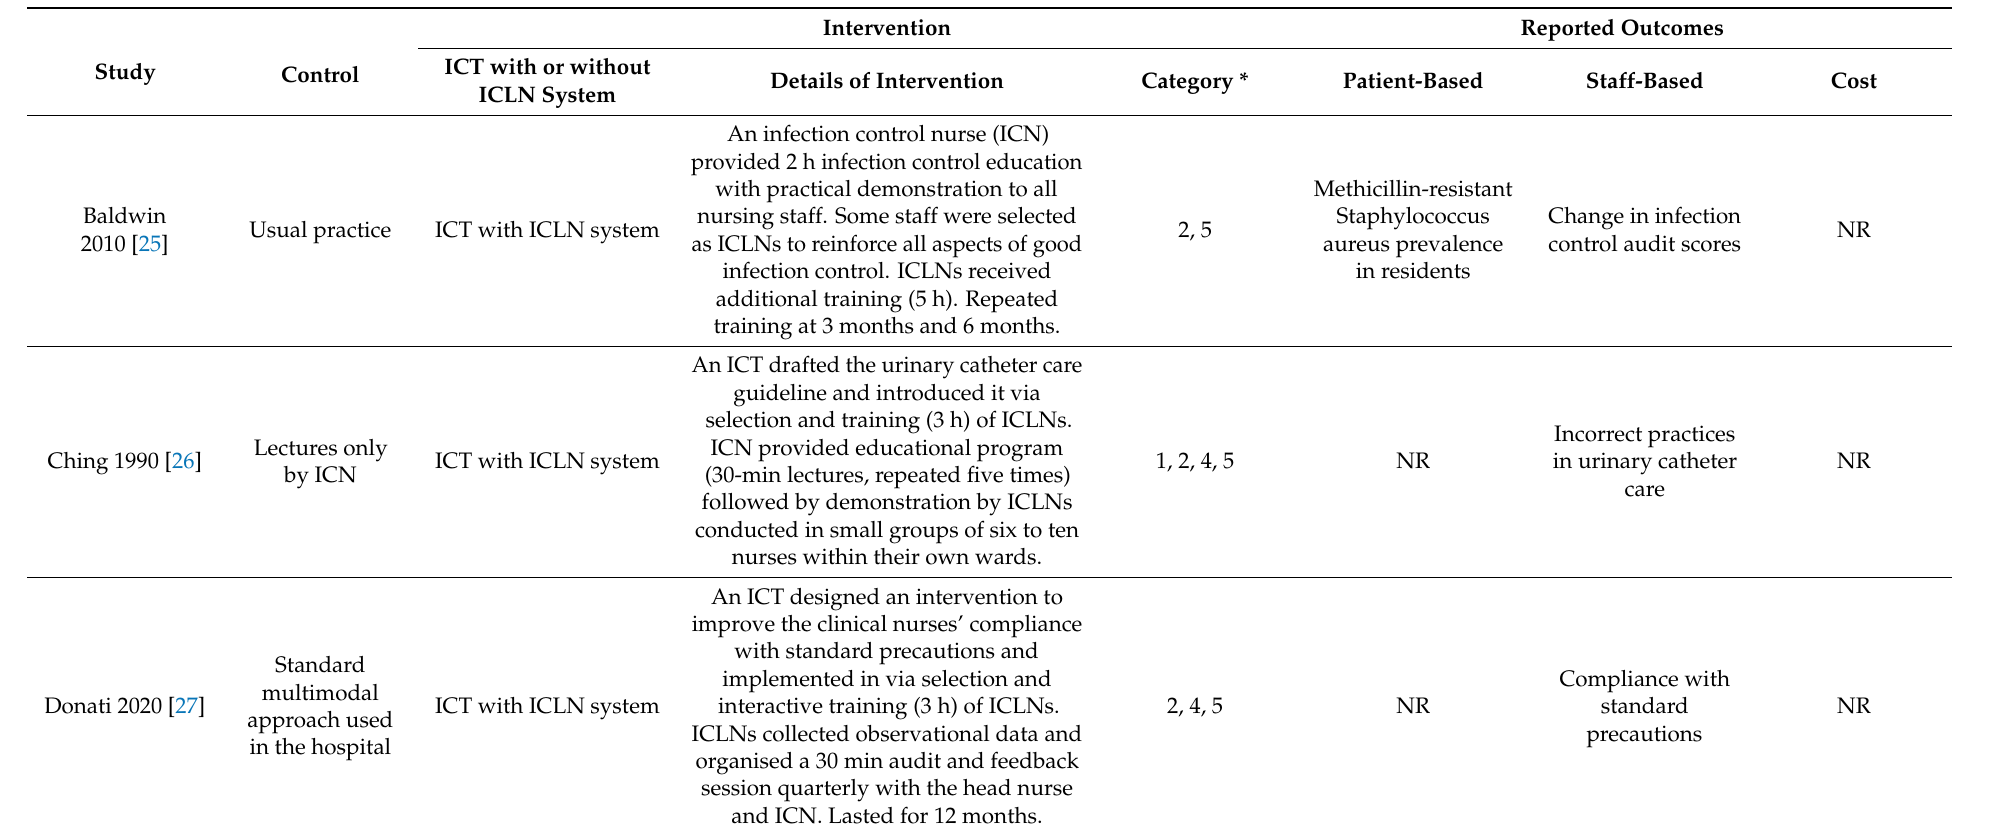
Table A1. Description of interventions and outcomes in included